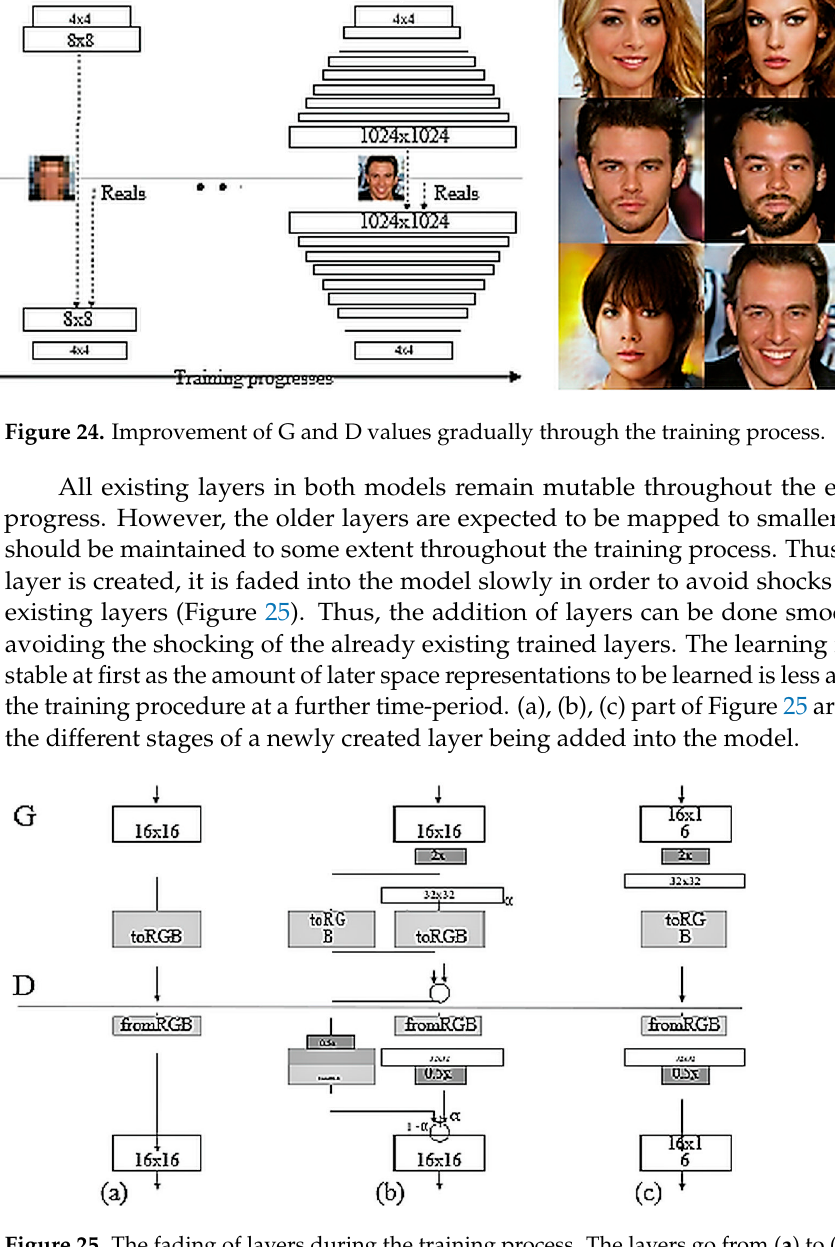
Figure 25. The fading of layers during the training process. The layers go from ( a ) to ( b ) by assuming the already-trained layers as a residual block where the weights move from 0 to